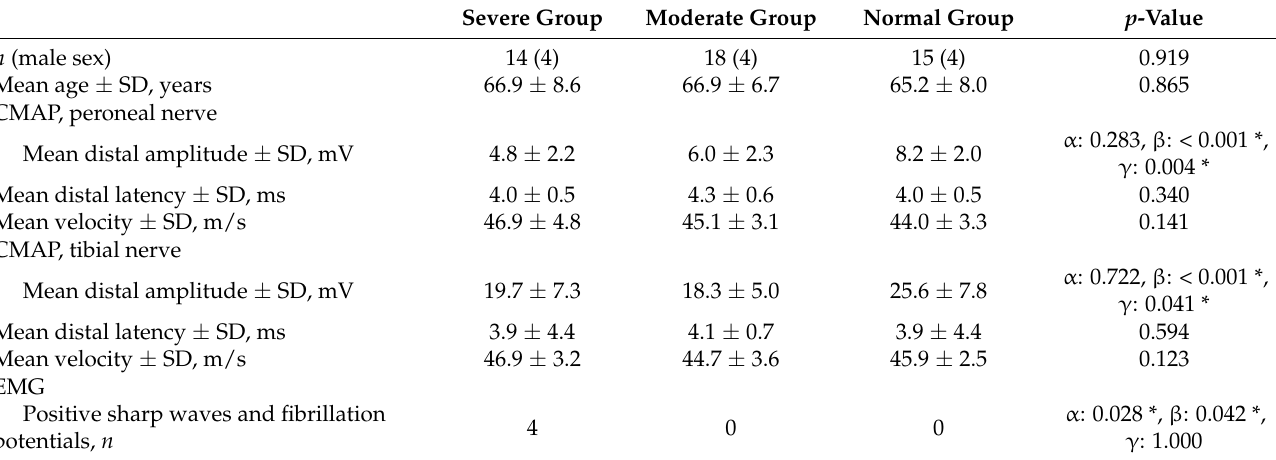
Table 1. Demographic and electrodiagnostic